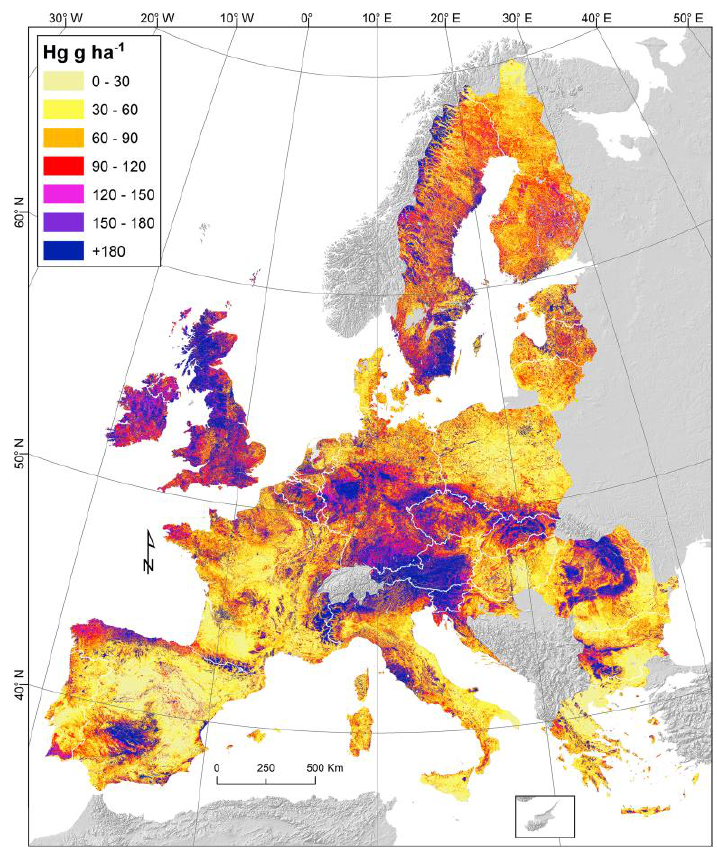
Figure 6. Hg stock (g ha − 1 ) in European topsoils [64].